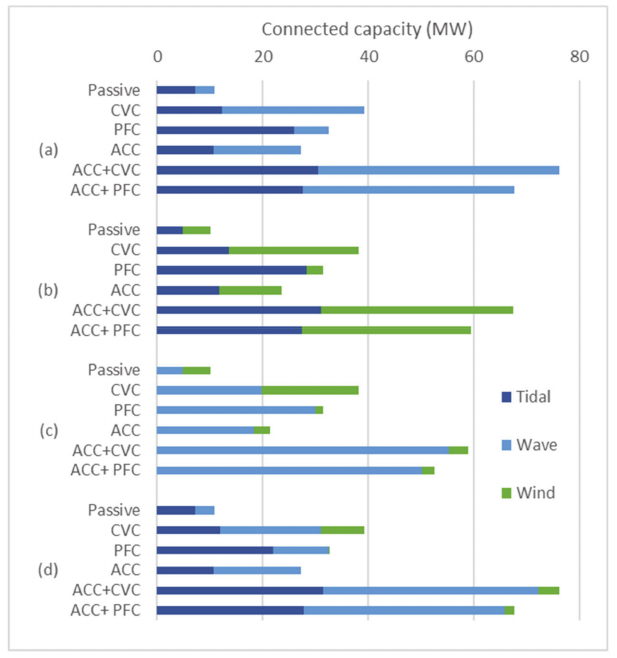
Figure 10. Capacity breakdown by resource type for hybrid cases with actively managed networks: ( a ) tidal + wave; ( b ) tidal + wind; ( c ) wind + wave and ( d ) tidal + wave + wind. Stack colour indicates the capacity of the individual